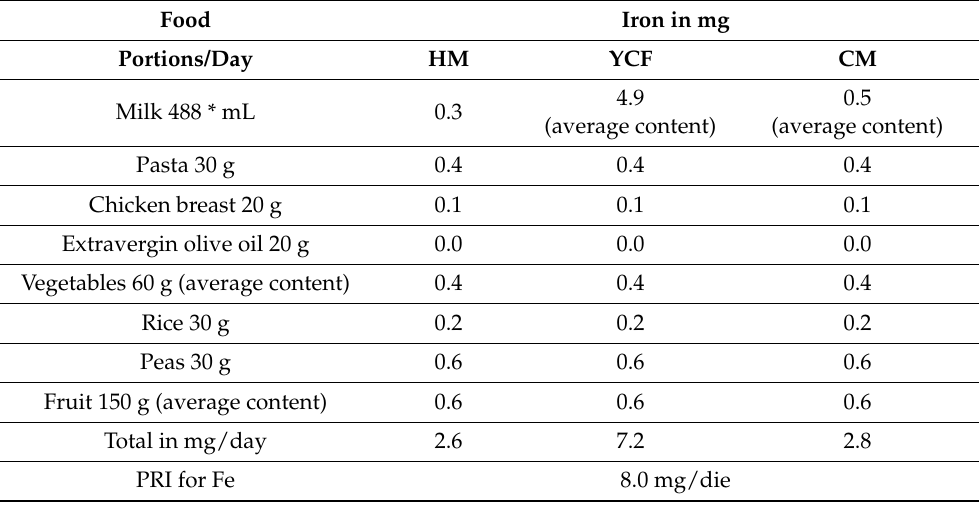
Table 6. Different iron intakes for an infant of around 18 months of age weighing approximately